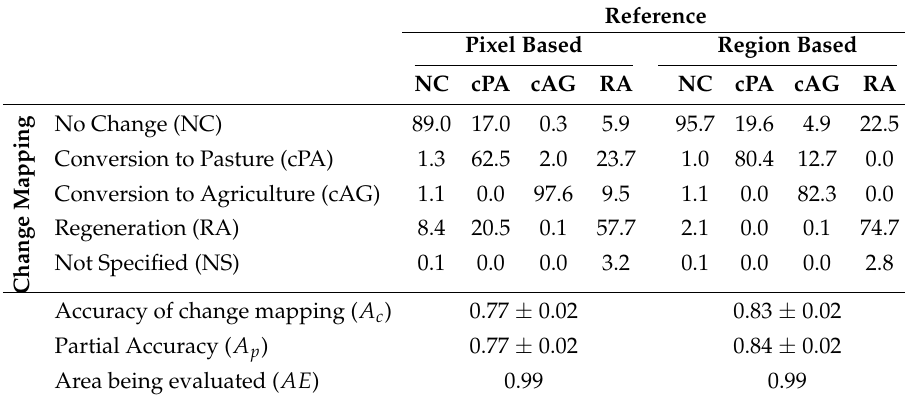
Table 7. Mean rectangular confusion matrices (%) and evaluation indexes for final change mappings using L2